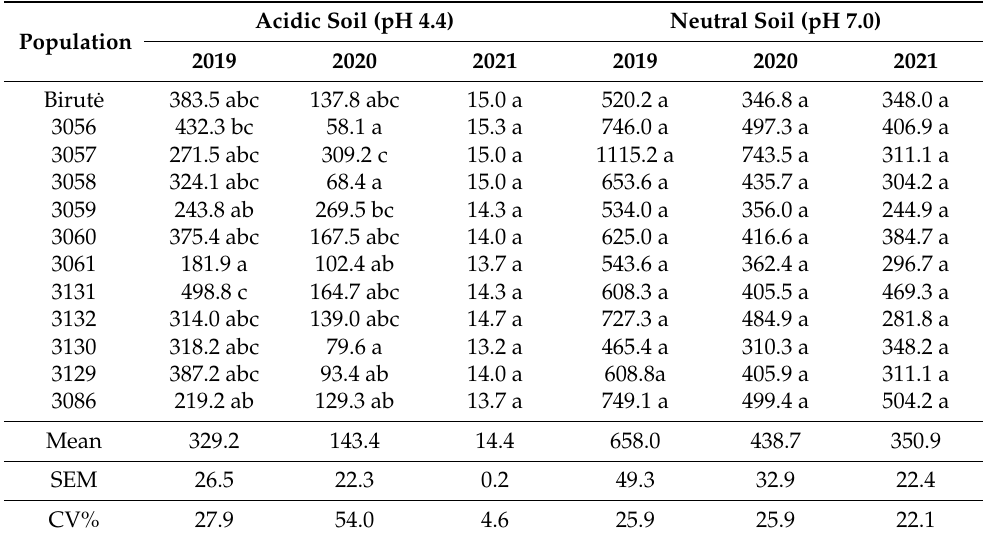
Table 8. The seed yield (kg ha − 1 ) under different experimental sites (I and II). Acidic Soil (pH 4.4) Neutral Soil (pH Population